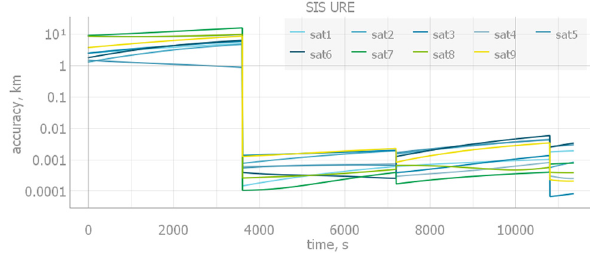
Figure 12: On - board OD accuracy.